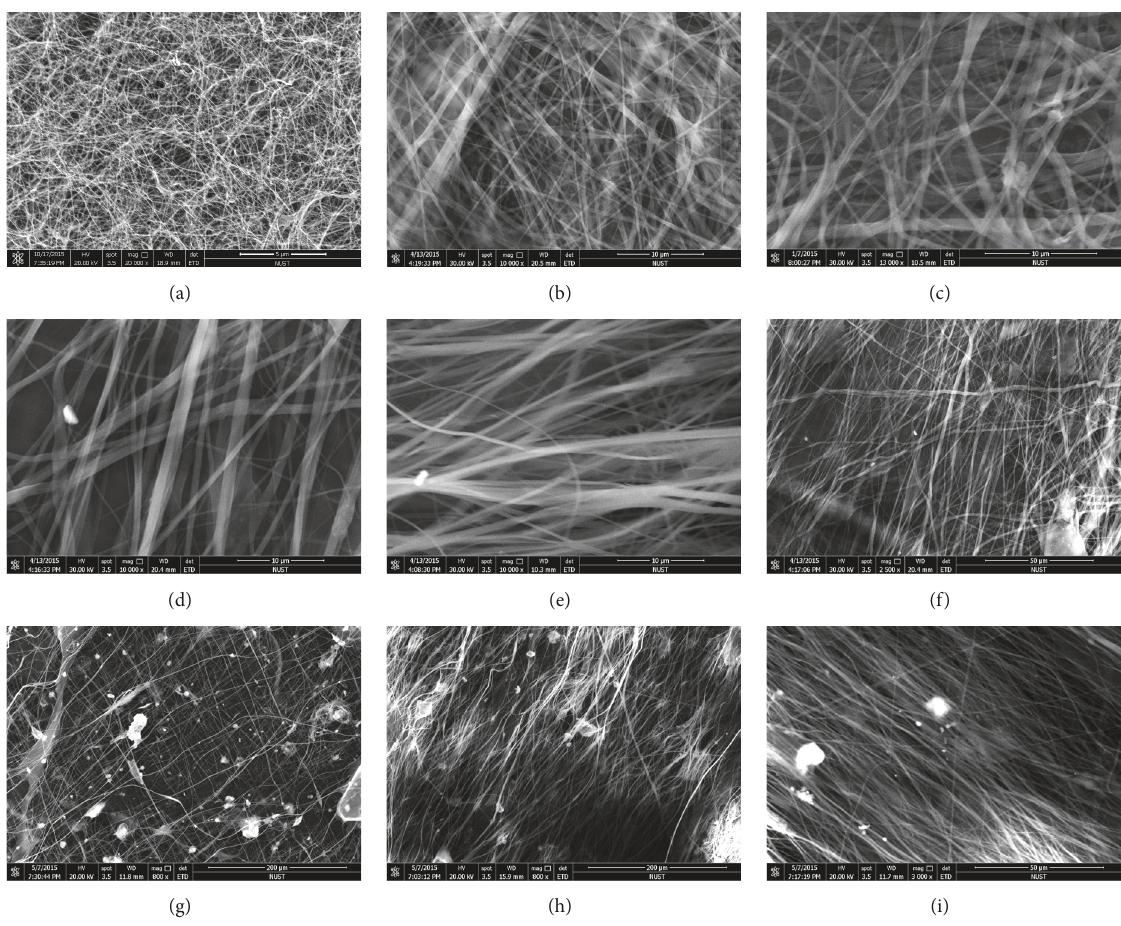
Figure 2: SEM photographs of (a) native BC, (b–f) regenerated BC fibers, (g) 0.1 g TiO 2 /1.35% BC, (h) 0.05g TiO 2 /1.35% BC, and (i) 0.01 g TiO 2 /%1.35 BC.